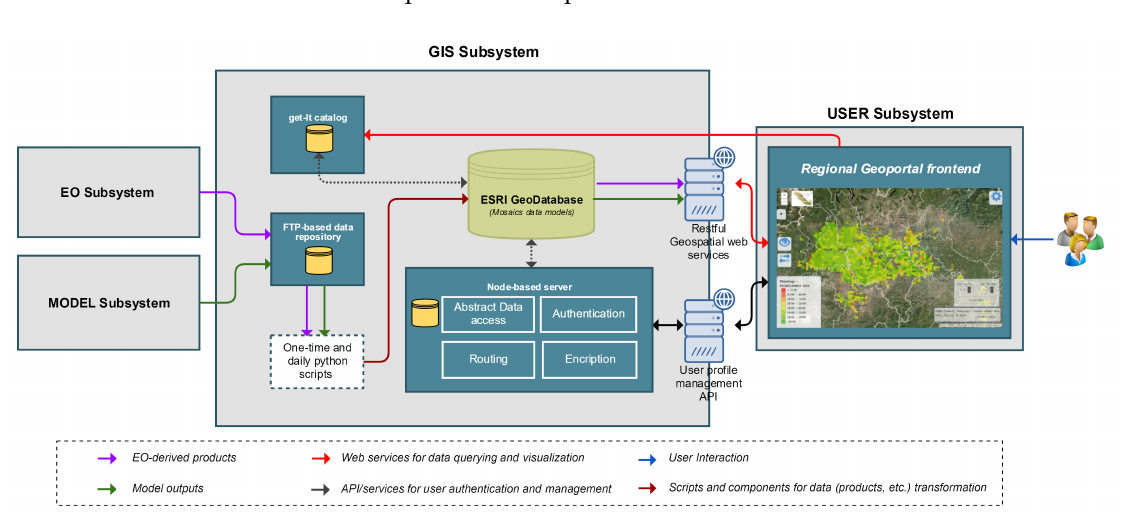
Figure 2. Server-side conceptual architecture and main components of the regional